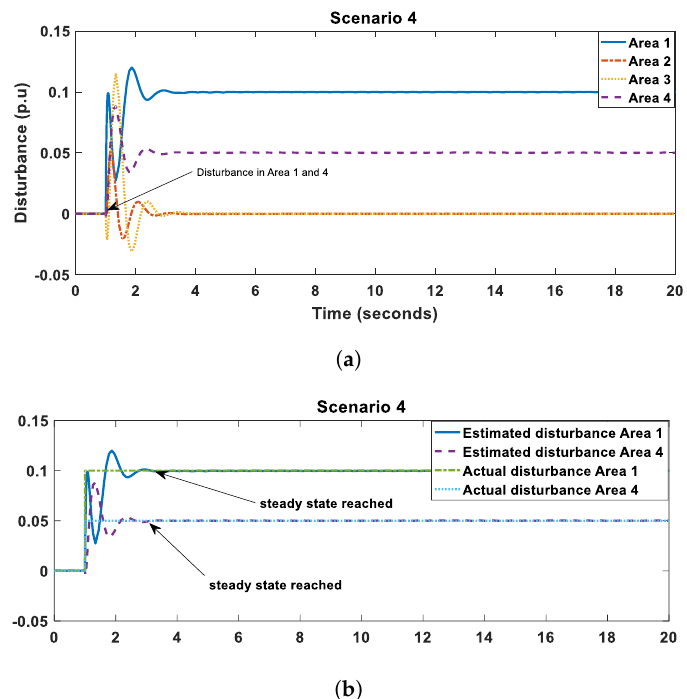
Figure 11. Scenario 4: ( a ) estimated disturbances and ( b ) actual vs. estimated